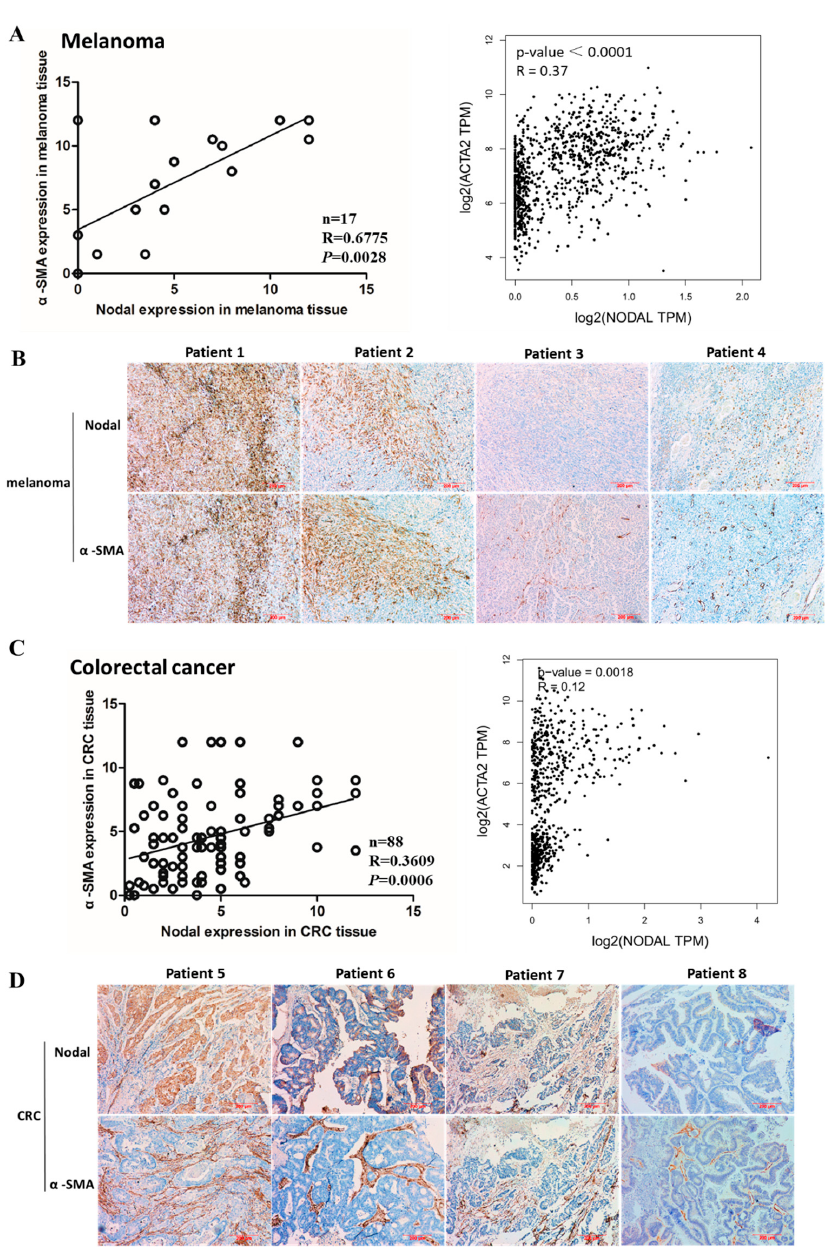
Figure 1. Correlation of α -smooth muscle actin ( α -SMA) and Nodal expression in human melanoma and colorectal cancer (CRC) tissues. ( A ) The expression level of α -SMA and Nodal in human melanoma were detected by immunohistochemistry (IHC) and evaluated (left). Correlation between α -SMA and Nodal mRNA expression in melanoma cancer tissues from the Cancer Genome Atlas Program (TCGA database; right). ( B ) Representative immunohistochemical images of α -SMA and Nodal expression in human melanoma tissues. ( C ) The expression levels of α -SMA and Nodal in human CRC were detected by IHC and evaluated (left). Correlation between α -SMA and Nodal mRNA expression in CRC tissues from TCGA database (right). ( D ) Representative immunohistochemical images of α -SMA and Nodal expression in human CRC tissues.